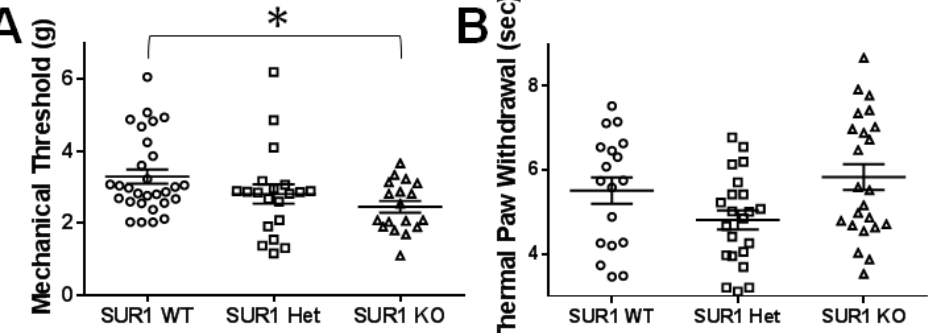
Figure 8. Mechanical paw withdrawal thresholds but not thermal paw withdrawal thresholds are decreased in male and female SUR1 KO mice compared to WT mice. ( A ) Mechanical paw withdrawal thresholds are significantly decreased in SUR1KO mice compared to WT mice (ANOVA, F(2, 64) = 3.85, P = 0.026; Tukey post-hoc test; 95% CI = 0.097 to 1.58). ( B ) Thermal withdrawal latencies were not significantly different between genotypes. Data across sex and age of age are aggregated since no significant differences were found.